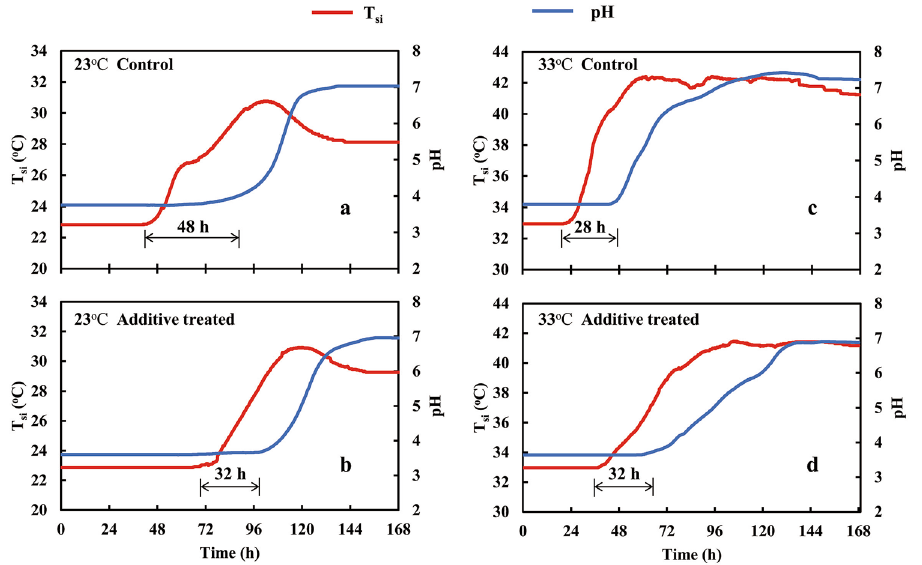
Figure 1. Silage temperature (T si ) and pH patterns in control ( a , c ) or biological additive-treated ( b , d ) maize silage samples incubated at 23 °C ( a , b ) or 33 °C ( c , d ) for 168 h of incubation (T c